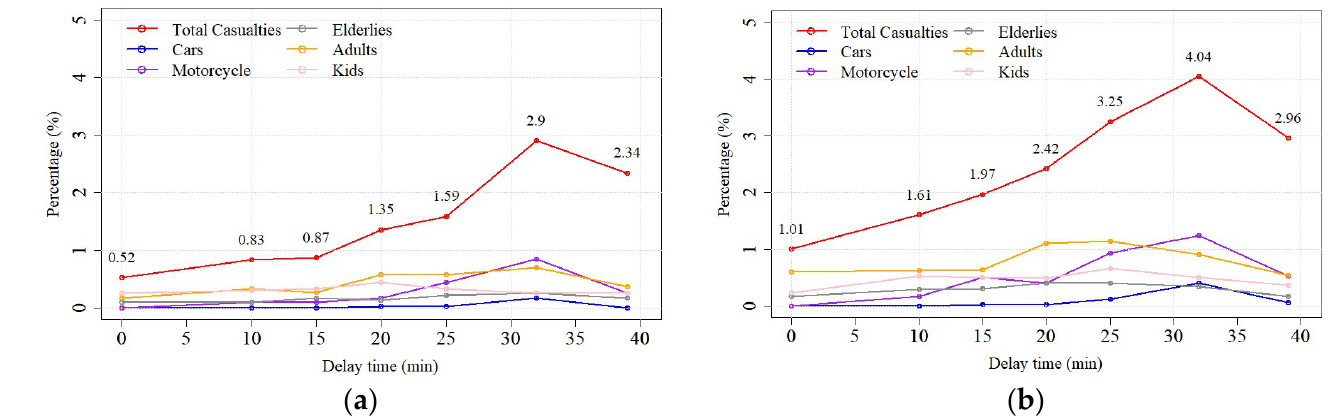
Figure 13. Comparison of the mortality rate from ( a ) the VESs and HES simulations and ( b ) the HES simulations